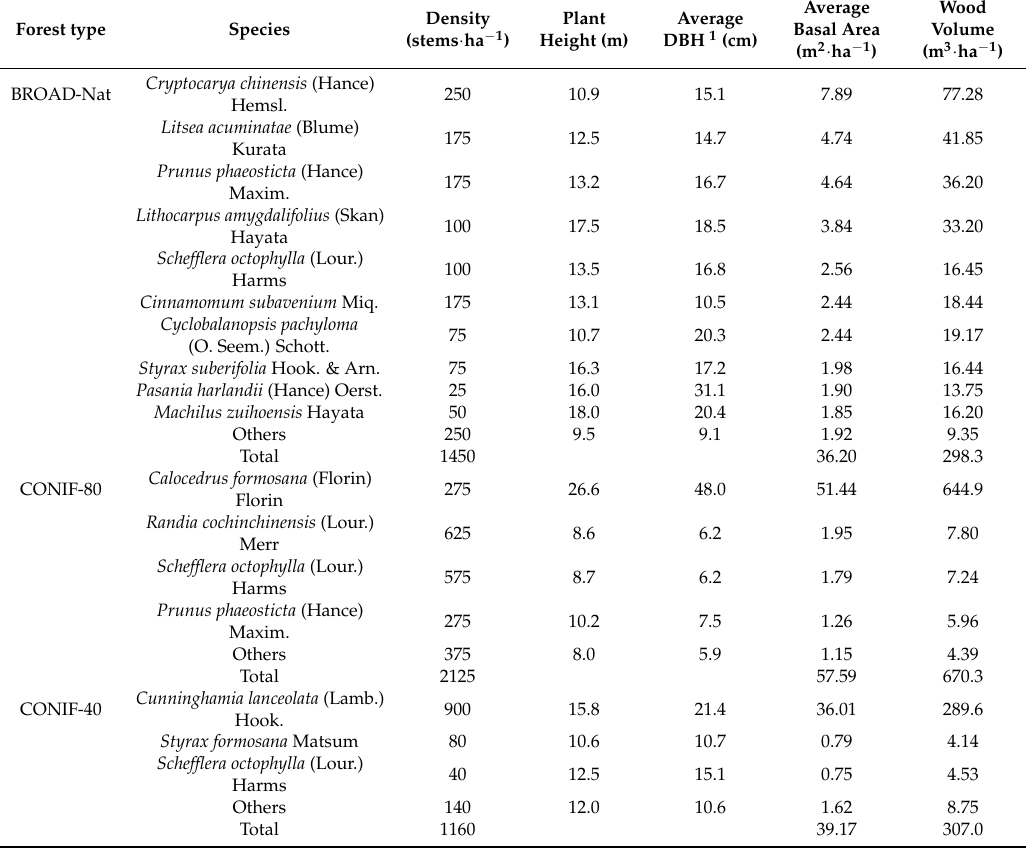
Table 1. Indices of natural broadleaf forest (BROAD-Nat), 80-year-old Calocedrus (CONIF-80) plantation, and 40-year-old Cunninghamia (CONIF-40) plantation at Lienhuachi Experimental Forest.